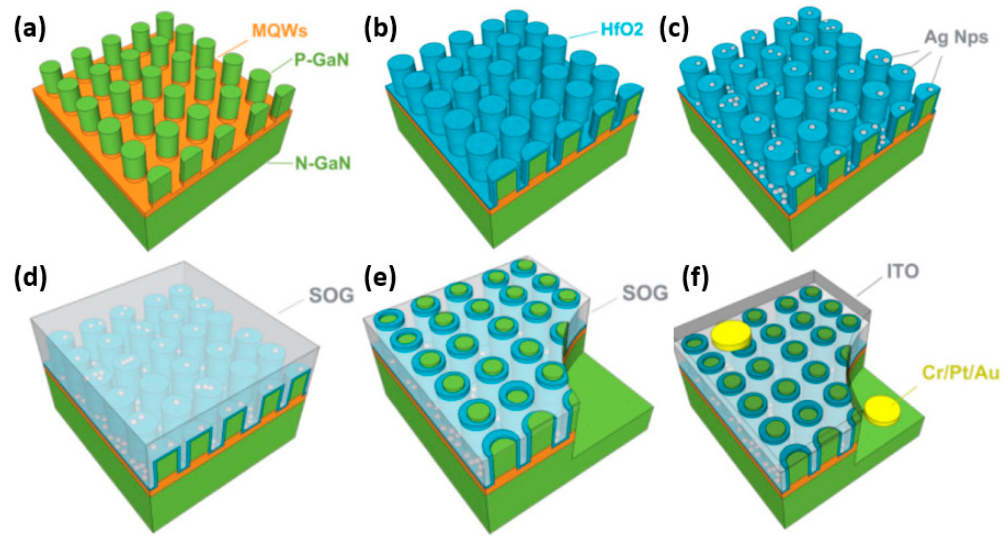
Figure 17. Schematic flow of GaN-based nanorod LED fabrication with Ag nanoparticles. [39] Figures reproduced with permission from Optical Society of America.